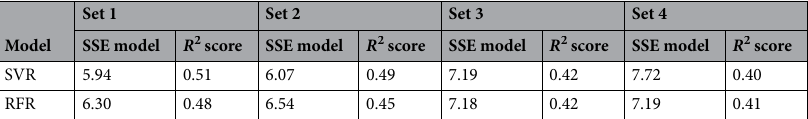
Table 2. Calculated SSE for the algorithm estimations against the actual values and R considered ML algorithm and feature